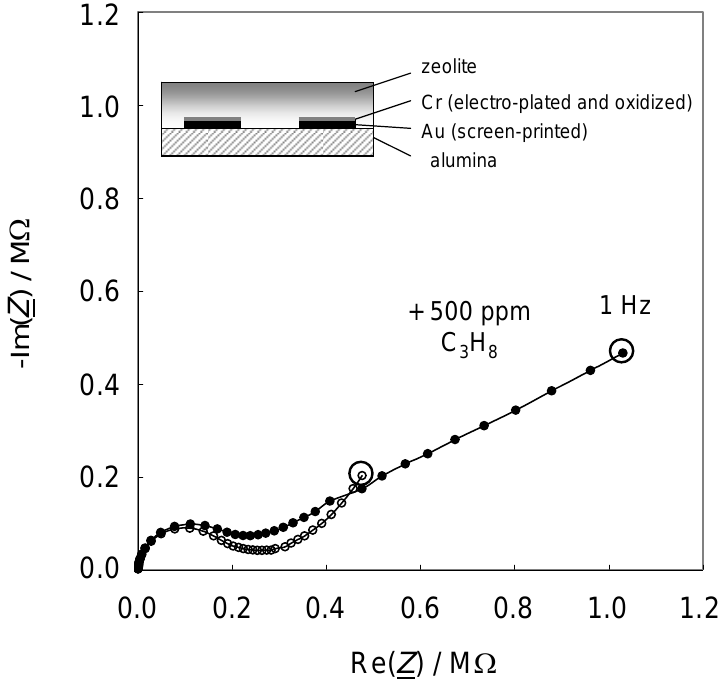
Figure 3. Nyquist plot of a thick film sensor with and without 500 ppm C impedance measured from 1 Hz to 10 MHz, 40 mV